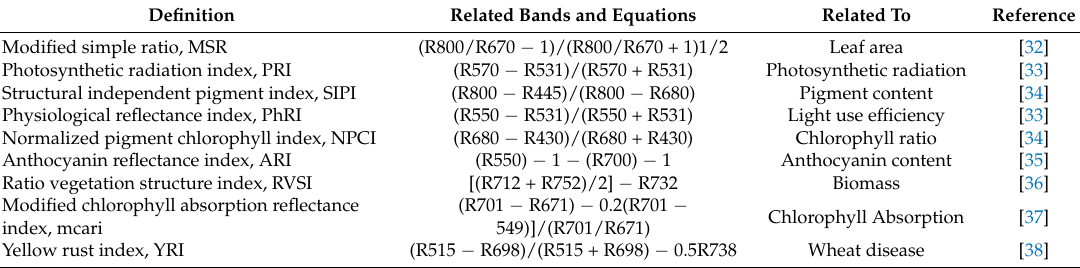
Table 2. Vegetation indices used as features for classifications in this